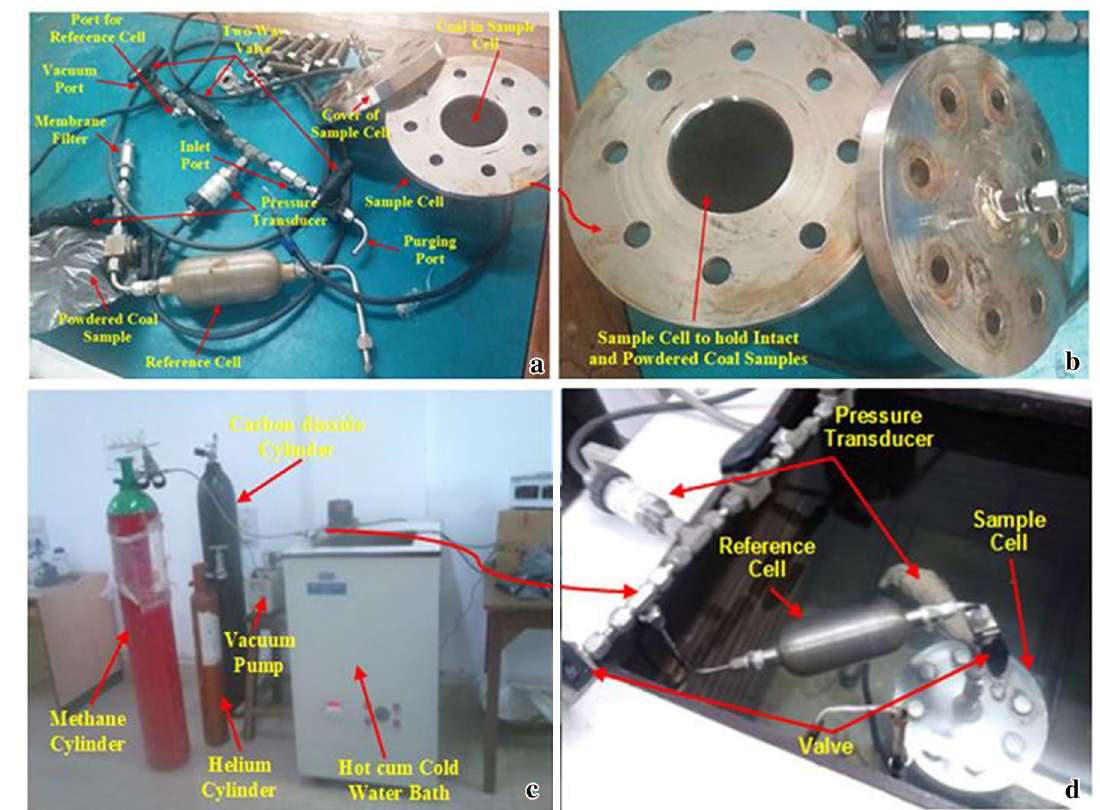
Fig. 3 Experimental setup for sorption test. a Detailed view of the different parts in setup. b Sample cell to hold intact as well as powdered coal samples. c Setup with gas cylinder as well as vacuum pump. d Setup in place